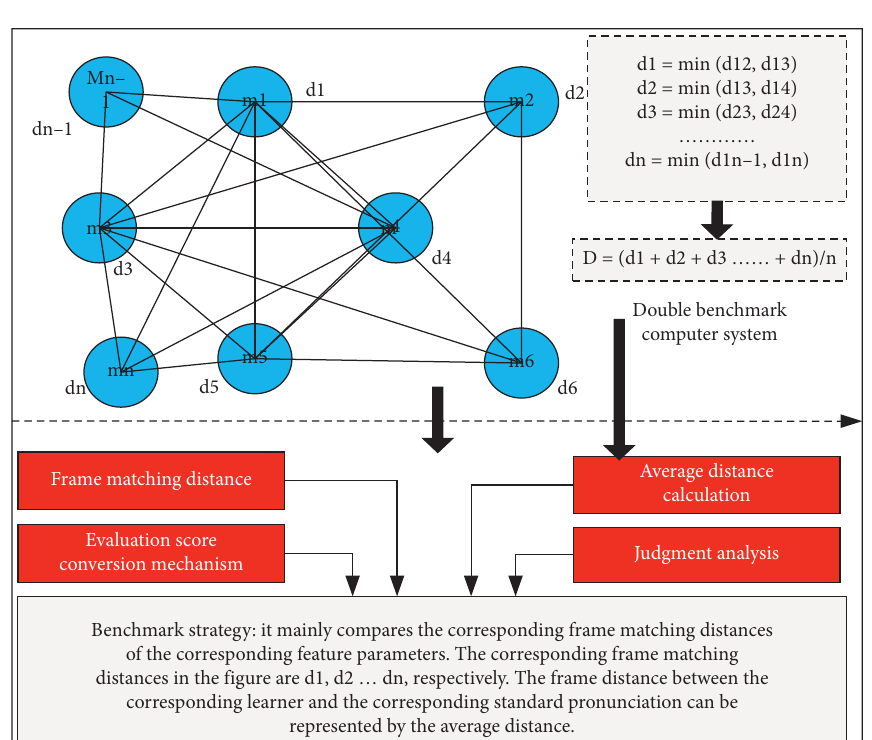
Figure 5: Evaluation mechanism of oral English pronunciation training based on the double standard evaluation